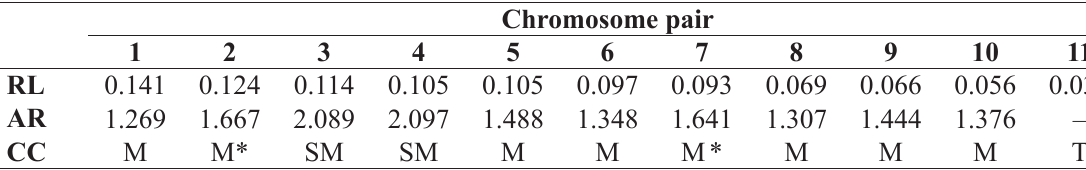
Table 5. Morphometric parameters of the chromosomes of Physalaemus araxa sp. nov.; chromosomal classification according to their centromeric position followed Green & Sessions (1991). Abbreviations: AR = arm ratio; RL = relative length; CC = centromeric classification: M = metacentric; SM = submetacentric; T = telocentric. Asterisks represent the pairs at the threshold between metacentric and submetacentric